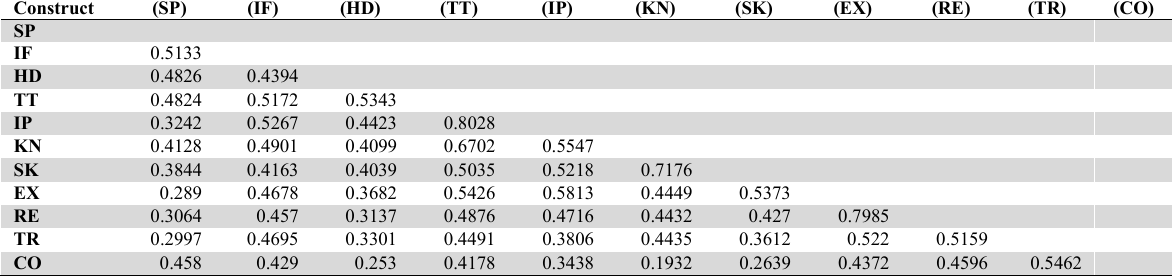
Discriminant validity- Heterotrait-Monotrait Ratio of Correlations Construct